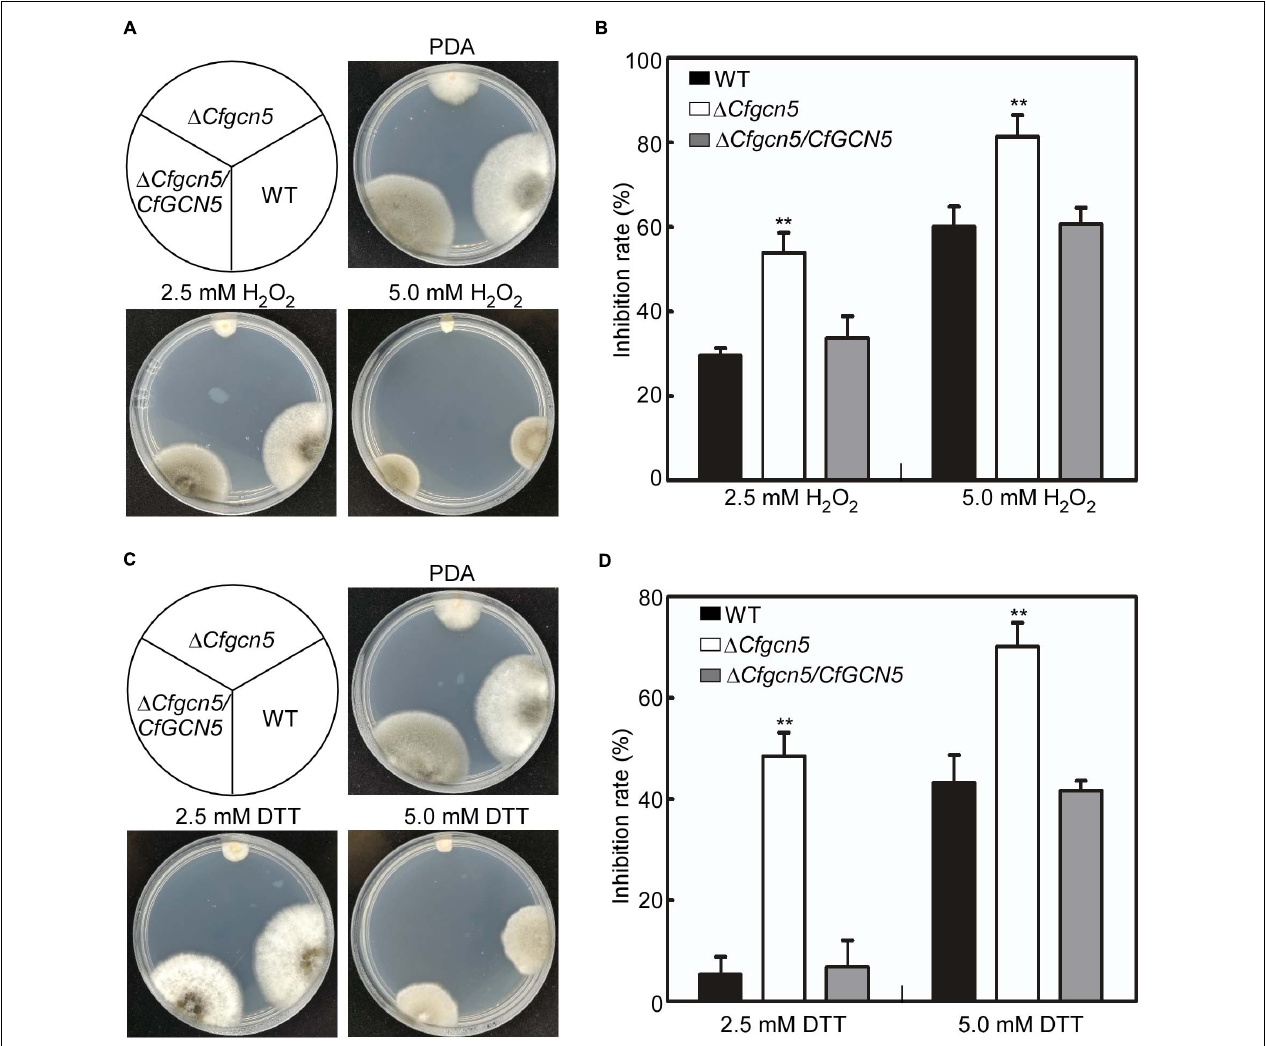
FIGURE 7 | CfGcn5 participates in the responses to oxidative and ER stresses. (A) The WT, (cid:49) Cfgcn5, and (cid:49) Cfgcn5 / CfGCN5 were incubated on PDA plates with 2.5 and 5.0 mM H 2 O 2 at 28 ◦ C for 4 days. (B) Statistical analysis of inhibition rates of the strains to H 2 O 2 stress. (C) The WT, (cid:49) Cfgcn5, and (cid:49) Cfgcn5 / CfGCN5 were incubated on PDA plates with 2.5 mM DTT and 5.0 mM DTT at 28 ◦ C for 4 days. (D) Statistical analysis of inhibition rates of the strains to DTT stress. Error bars represent SD of three replicates and asterisks indicate significant difference ( P <